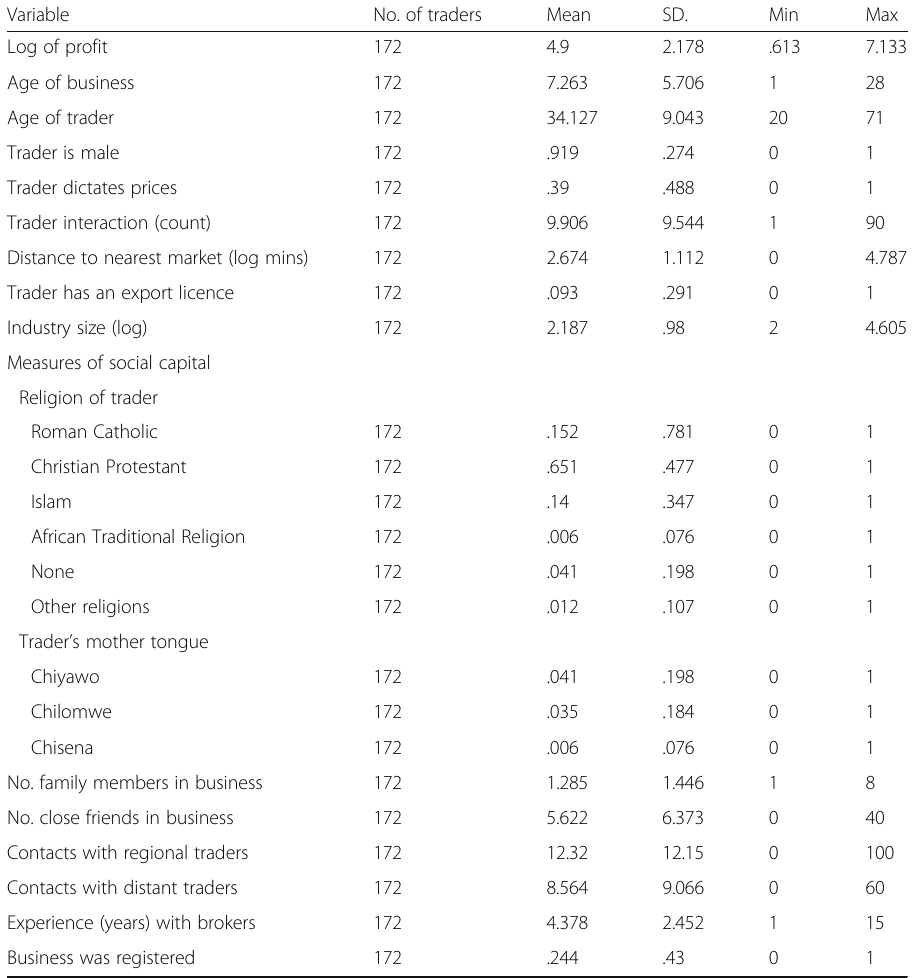
Table 3 Descriptive statistics of key variables used in the study Variable No. of traders